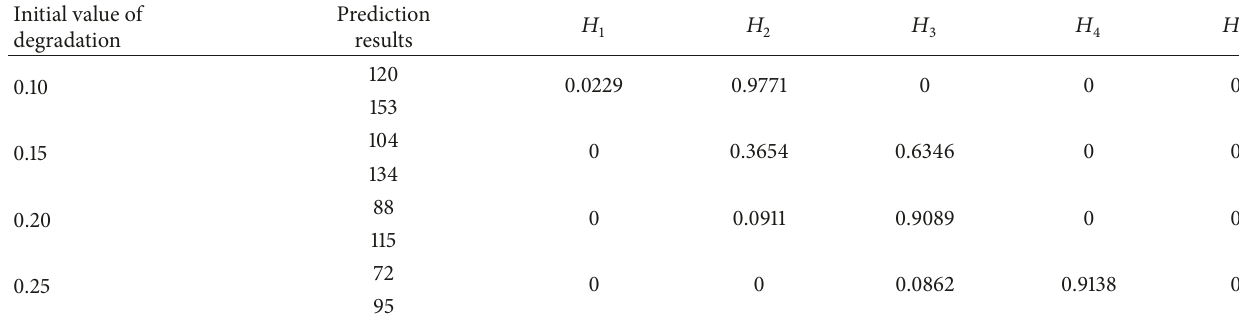
Table 7: The integration